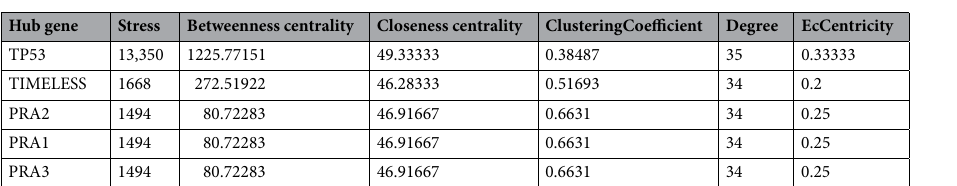
Table 4. Topological diagram of the top five hub